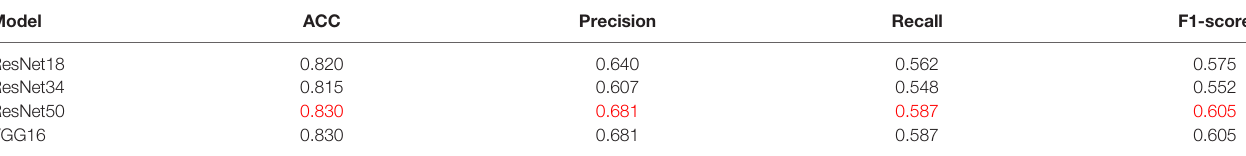
TABLE 2 | Comparison of the performance of different models (TMB cutoff = 10).